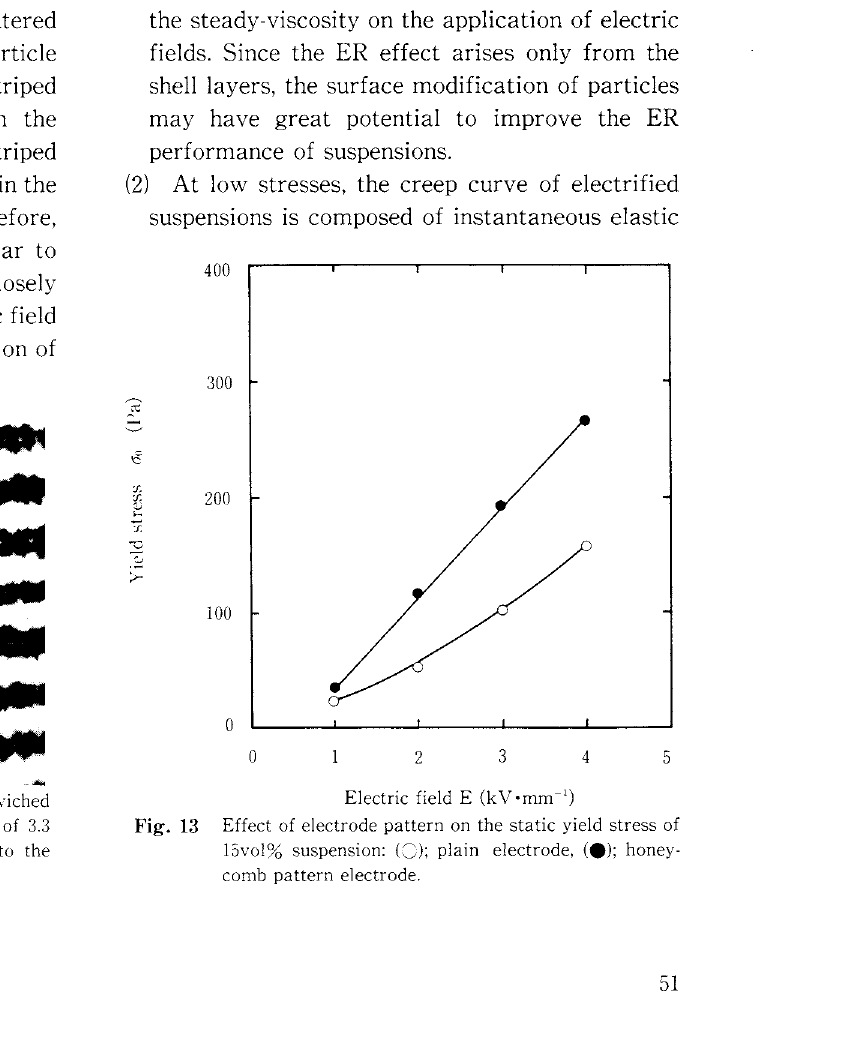
Fig. 13 Effect of electrode pattern on the static yield stress of lSvol% suspension: (::::;); plain electrode, Cel; honey comb pattern